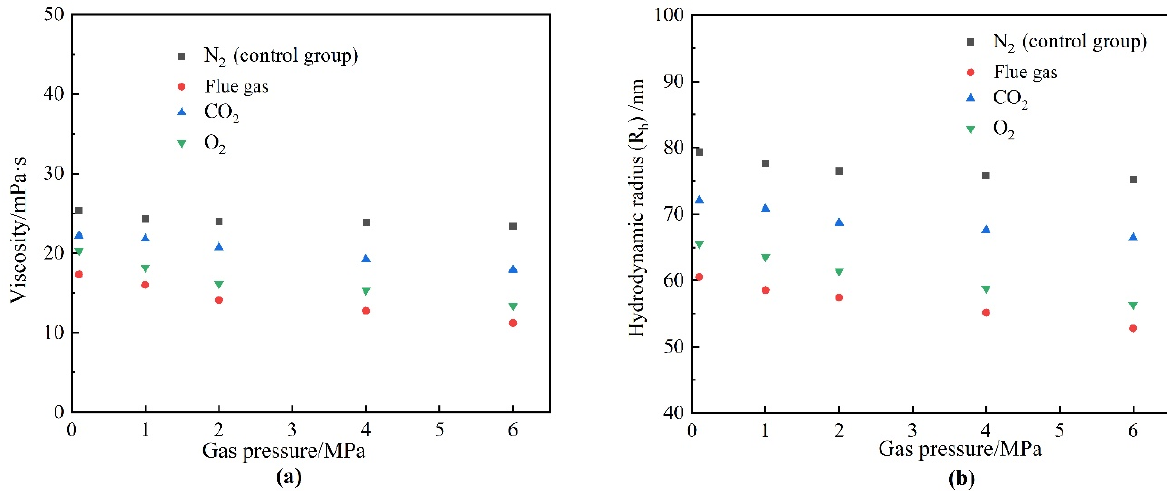
Figure 11. The properties of HPAM after aging for 180 days in different gases as a function of gas pressure. ( a ) Viscosity; ( b ) hydrodynamic radius (R h ).